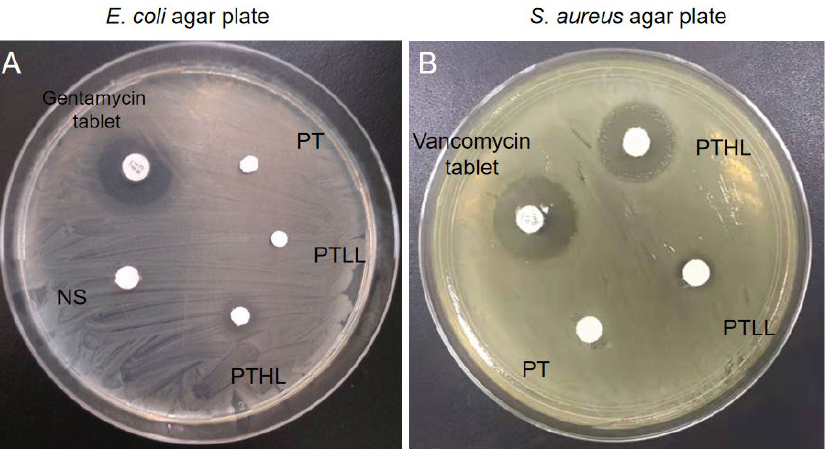
Figure 3. In vitro antibacterial activity of PLGA/TCP/LL-37 grafts in E. coli ( A ) and S. aureus ( B ) agar plates. Gentamycin tablets and vancomycin tablets were used as positive controls; PT is the PLGA/β - TCP blank group; PTLL is the PLGA/β -TCP/low concentration LL-37 group; PTHL is the PLGA/β -TCP/high concentration LL-37 group; NS is the tablet with normal saline group, as the negative control in this experiment.